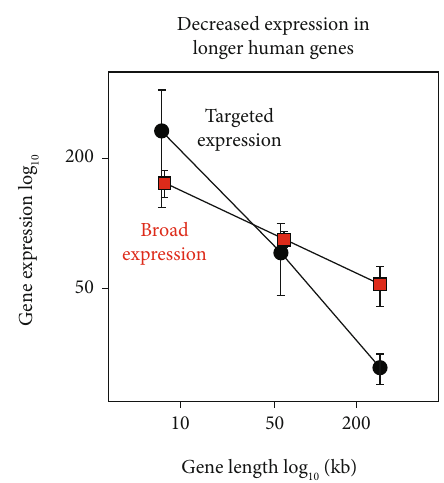
Figure 3: Expression of all database genes in the short, midlength, and long groups. Genes with tissue-targeted expression (RPKM) are shown in black, and those with broad expression (TPM) are shown in red. Note that gene expression is higher in short compared to long genes in both populations. Note also the greater range of expression values in tissue-targeted compared to broadly expressed